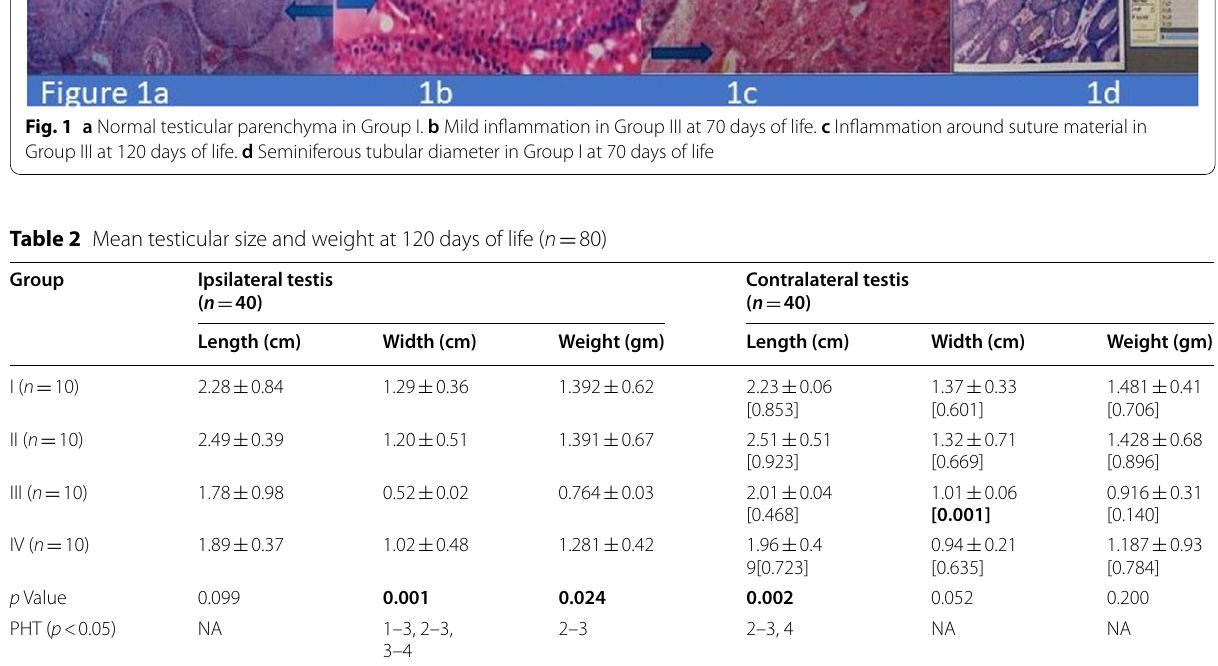
Data presented in mean standard deviation. One-way ANOVA test used between four (I, II, III, IV) groups followed by Post hoc test.; Independent samples t test used ± between ipsilateral hemi testis and contralateral hemi testis. PHT